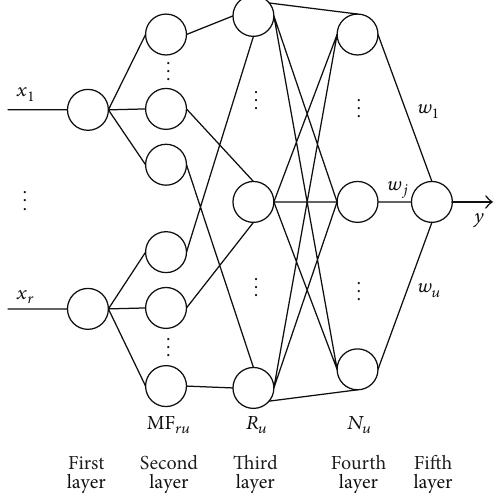
Figure 4: The structure of